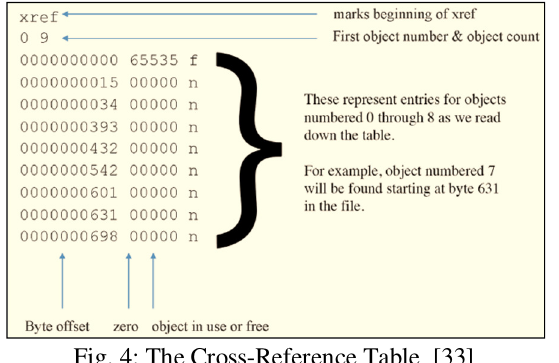
Fig. 4: The Cross-Reference Table [33]